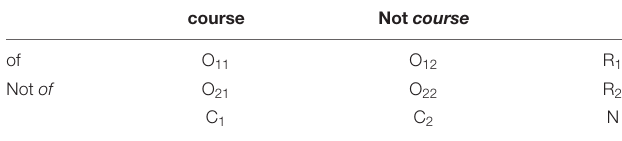
TABLE 2 | Co-ocurrence frequency table for calculation of association